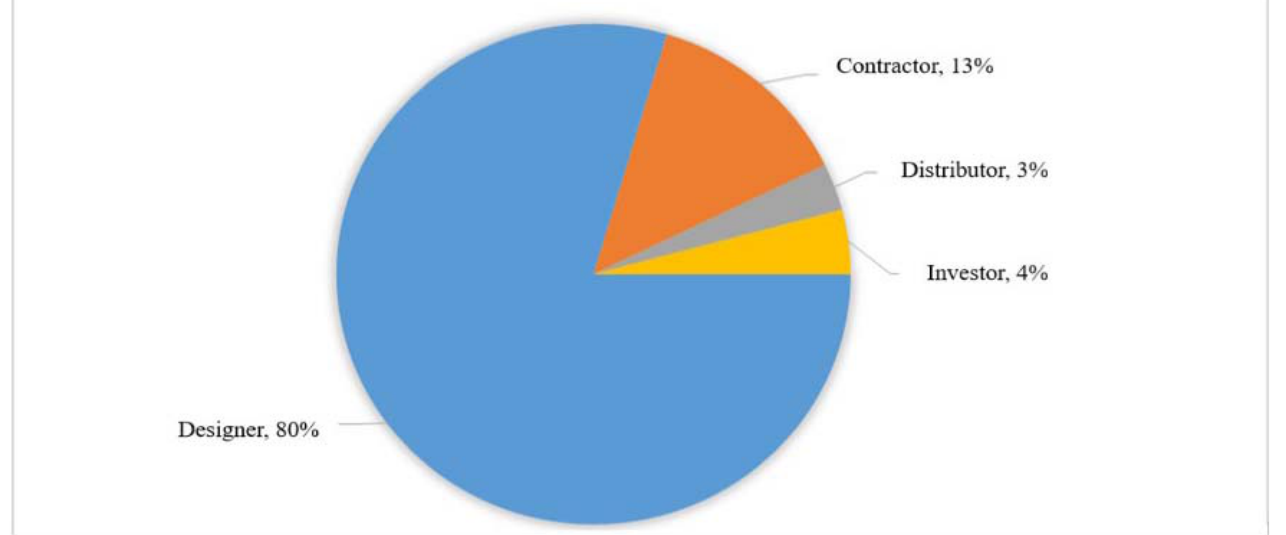
Fig. 1. Respondent profile